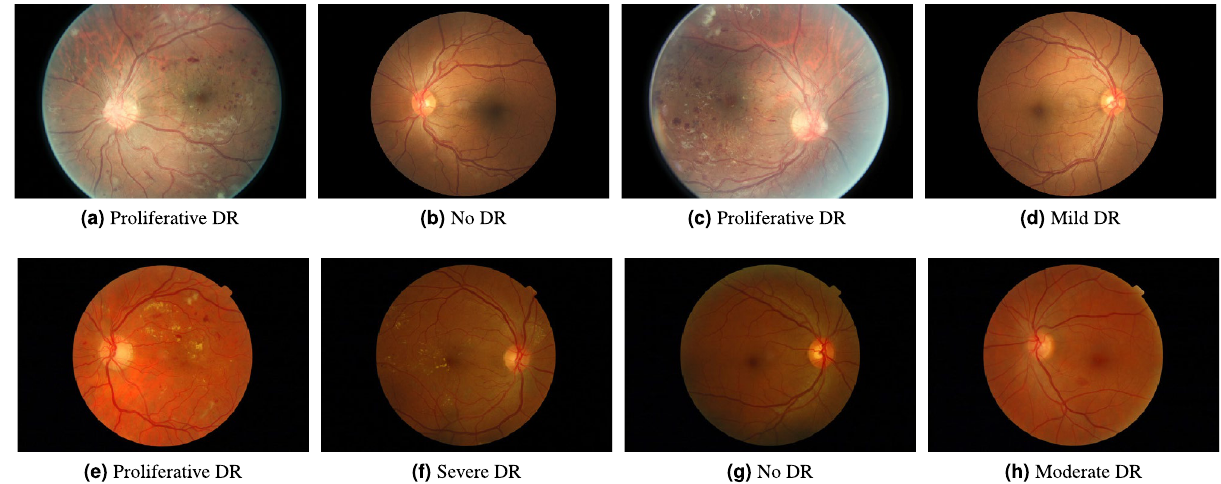
Figure 1. Sample images from the Kaggle-EyePACS dataset (top row) and the Messidor-2 dataset (bottom row) with their corresponding DR grades. The first row also showcases the two types of fundus images contained in Kaggle-EyePACS, i.e. images where the circular disk of the eye is fully captured (right column) or images where the circular disk is partially clipped (left column).